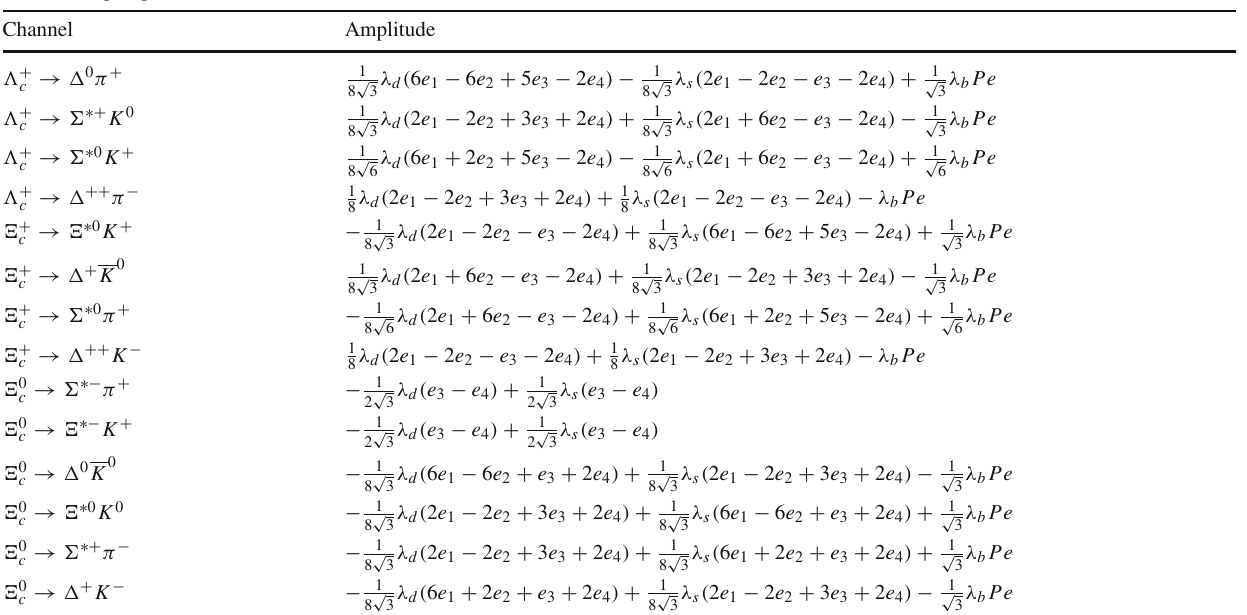
→ B 10 M decays, in which only those modes that all initial and final states have c 3